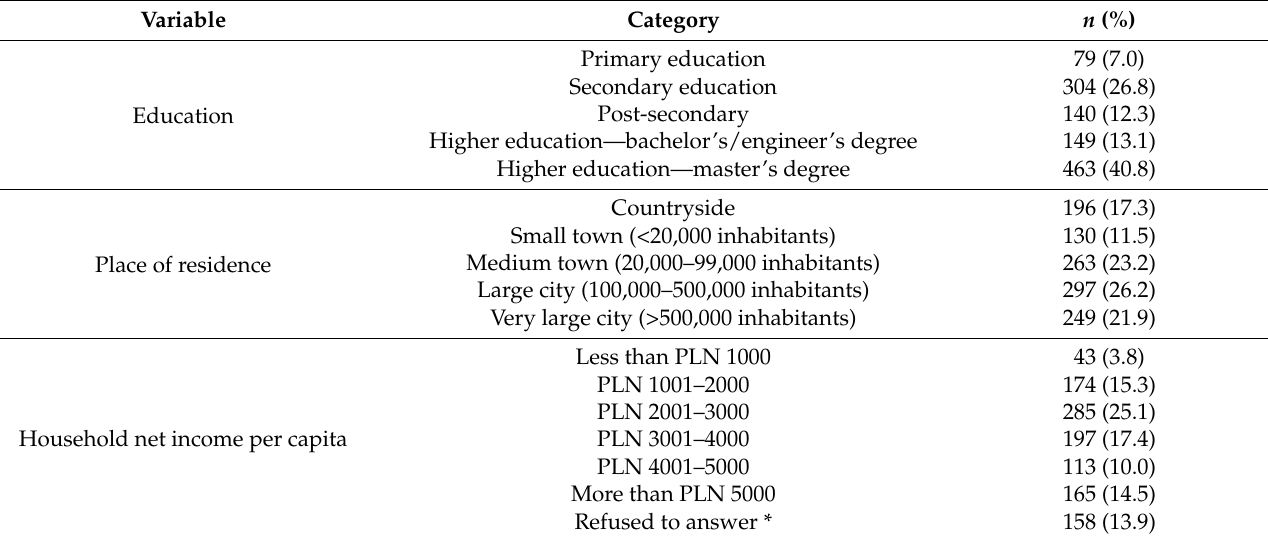
Table 1. Descriptive statistics for the socioeconomic